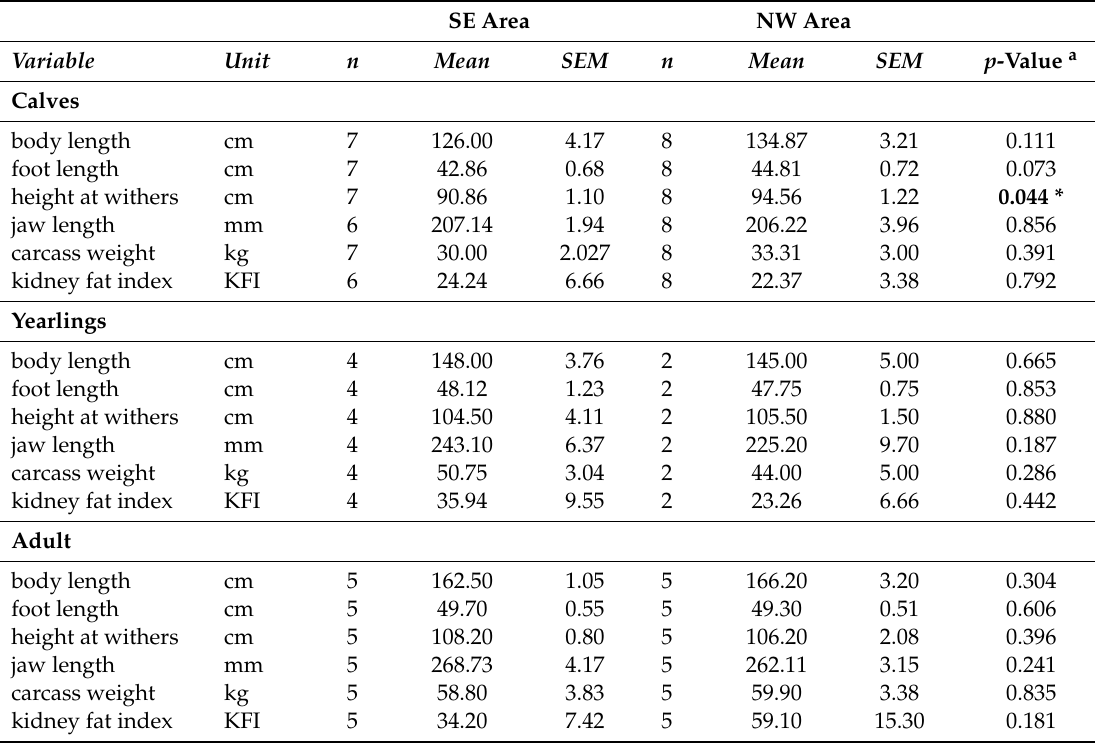
Table 2. Descriptive statistics (number of animals, means, SEM) of biometrical measures and nutritional index (KFI) in each geographic area (SE and NW). Significant di ff erences ( t -test) are highlighted in bold. SE